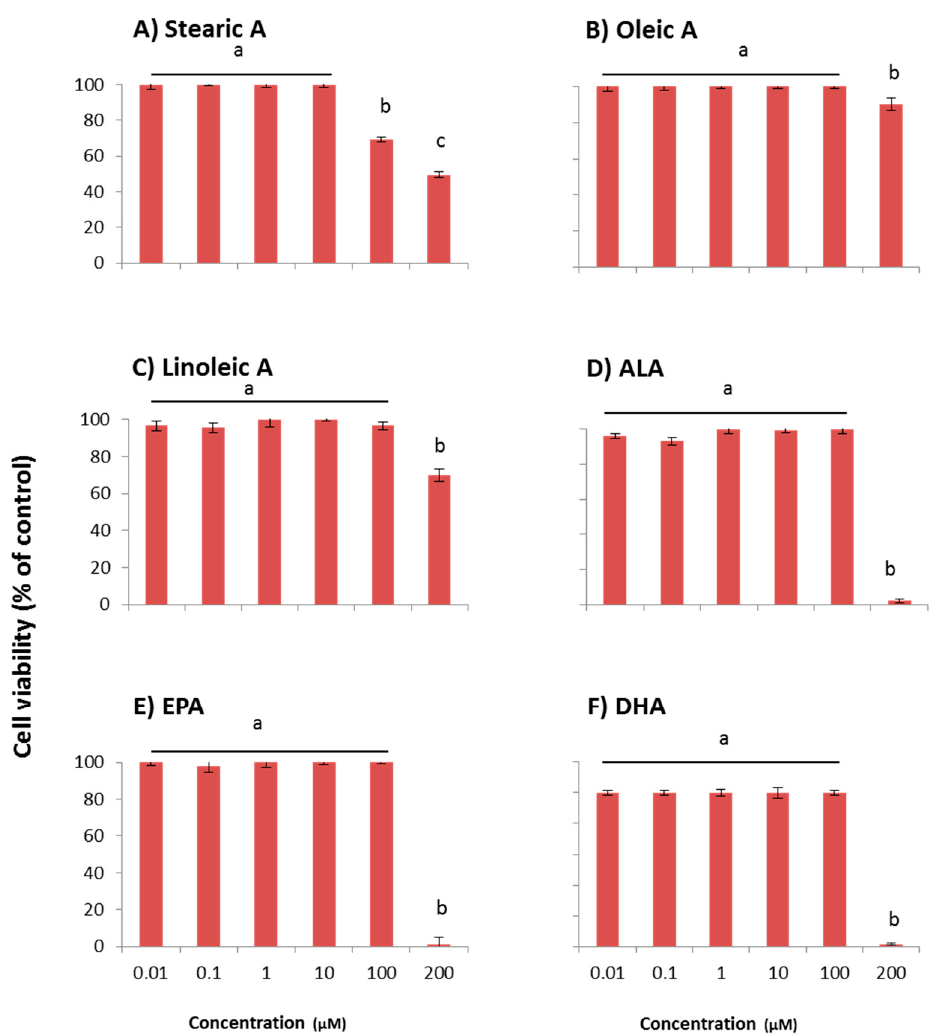
Figure 5. Dose-dependent cytotoxic effect of free fatty acids in WI-38 cells; ( A ) Stearic acid; ( B ) Oleic acid; ( C ) Linoleic acid; ( D ) ALA; ( E ) EPA; ( F ) DHA. Cells were pre-incubated with free fatty acids for 48 h. Cell viability was presented as percentage related to the control. Control contains cells with no incubation of free fatty acids. Data are expressed as mean ± SEM ( n = 6), means sharing the same letter within compound are not significantly different ( p ≤ 0.05).